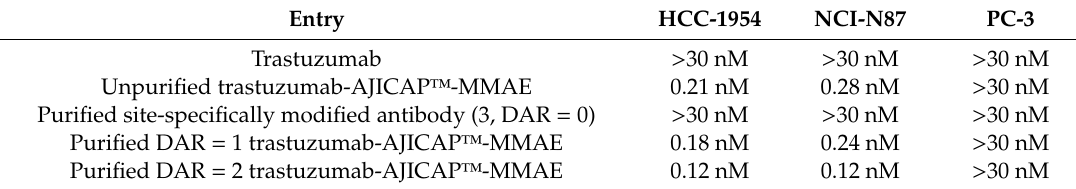
Table 2. IC 50 Values of trastuzumab-AJICAP ™ -MMAE